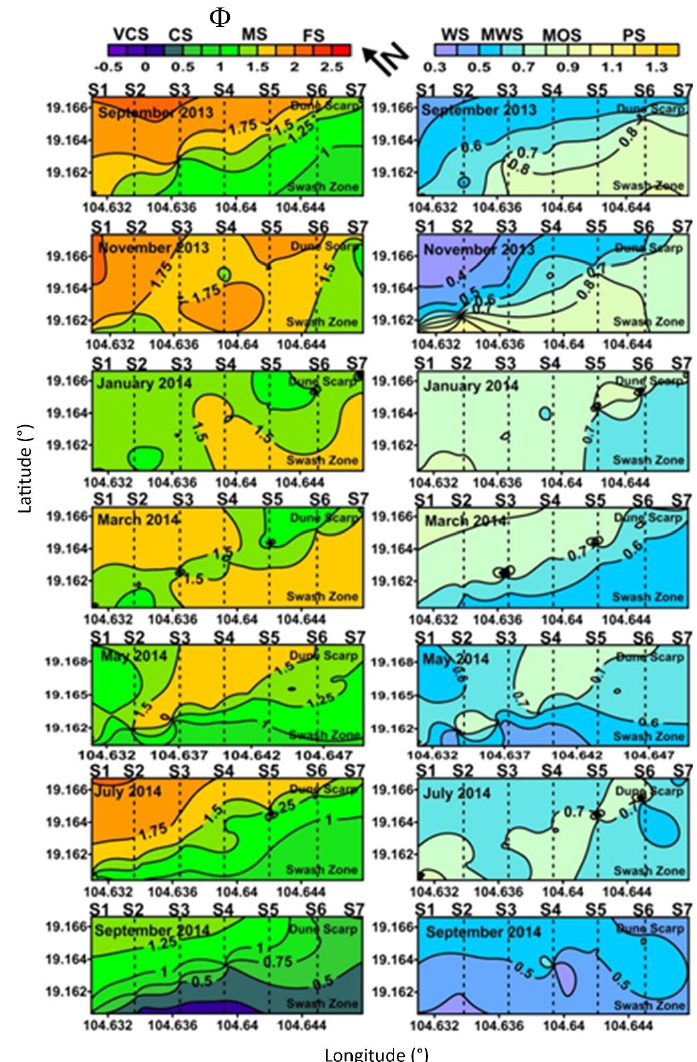
Figure 3. Mean sediment size and sorting recorded bimonthly from September 2013 to September 2014. Left panel; size legend bar: VCS (very coarse sand), CS (coarse sand), MS (medium sand), and FS (fine sand). Right panel; sorting legend bar: WS (well-sorted), MWS (moderately well-sorted), MOS (moderately sorted), and PS (poorly sorted).